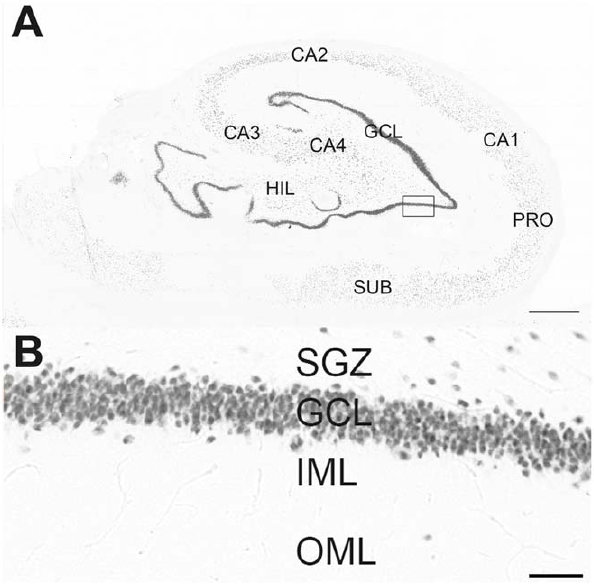
Figure 1. Subfields in the hippocampal formation under NeuN immunohistochemistry. In A can be seen: the granule cell layer of fascia dentata (GCL, composed by granular neurons) and the hilus (HIL, composed by several types of interneurons); pyramidal neuronal layers of the hippocampus (CA4-CA1); the subicular formation, composed by prosubiculum (PRO) and subiculum (SUB). In B, a higher magnification of the fascia dentate (marked as a black square in A), composed by subgranule zone (SGZ), granule cell layer (GCL), inner molecular layer (IML) and outer molecular layer (OML). Bar in A indicates 1 millimeter and in B indicates 50